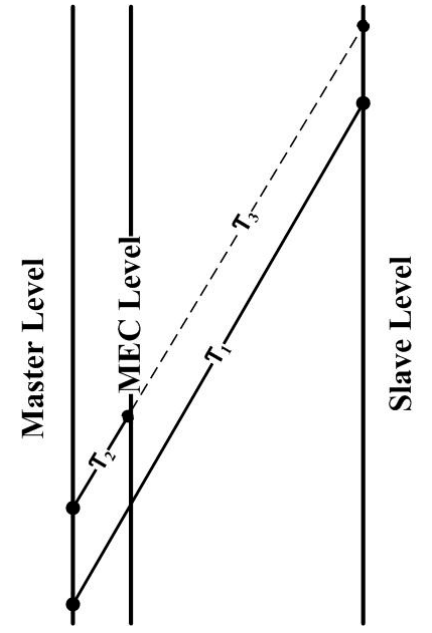
Figure 9. Time graph for the tactile Internet system.